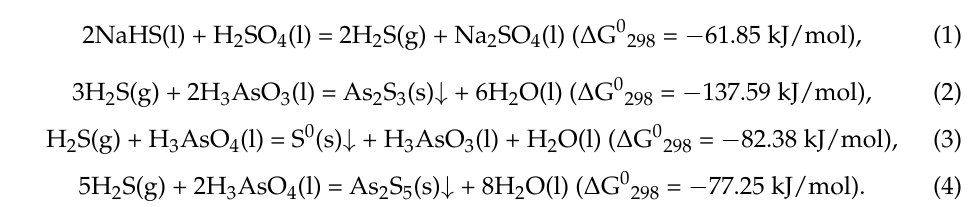
Figure 1. Pourbaix diagram of As-S-H 2 O system at 25 ° С .